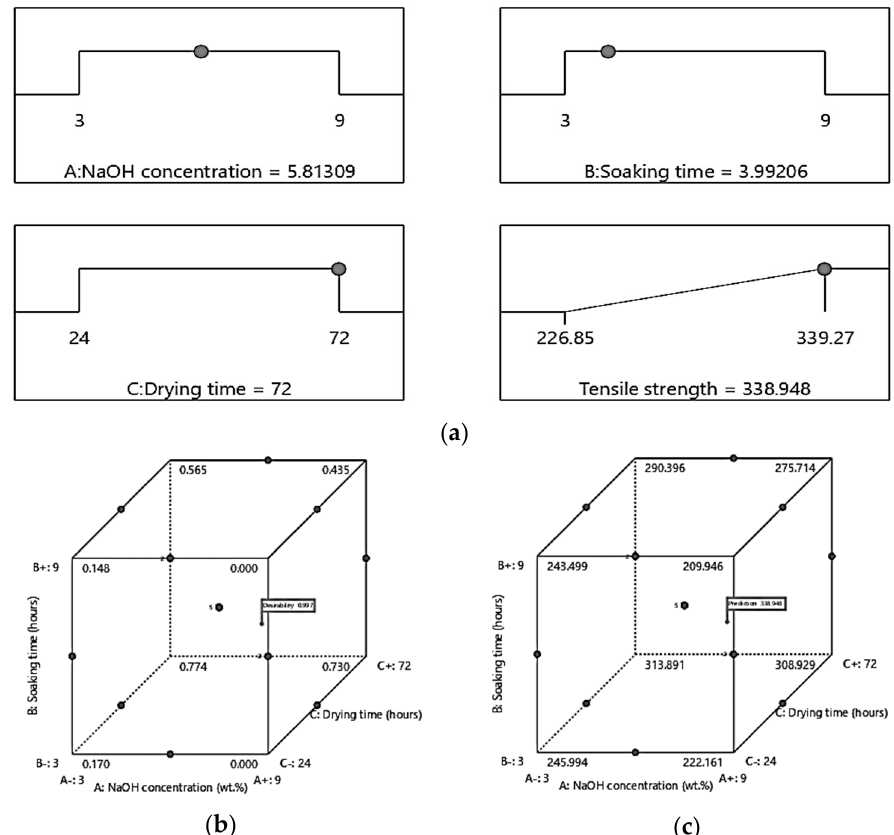
Figure 8. Typical ( a ) ramp, ( b ) desirability cube and ( c ) tensile strength cube represent the effect of NaOH concentration, soaking time and drying time under optimal conditions. Polymers 2020 , 12 , x FOR PEER REVIEW